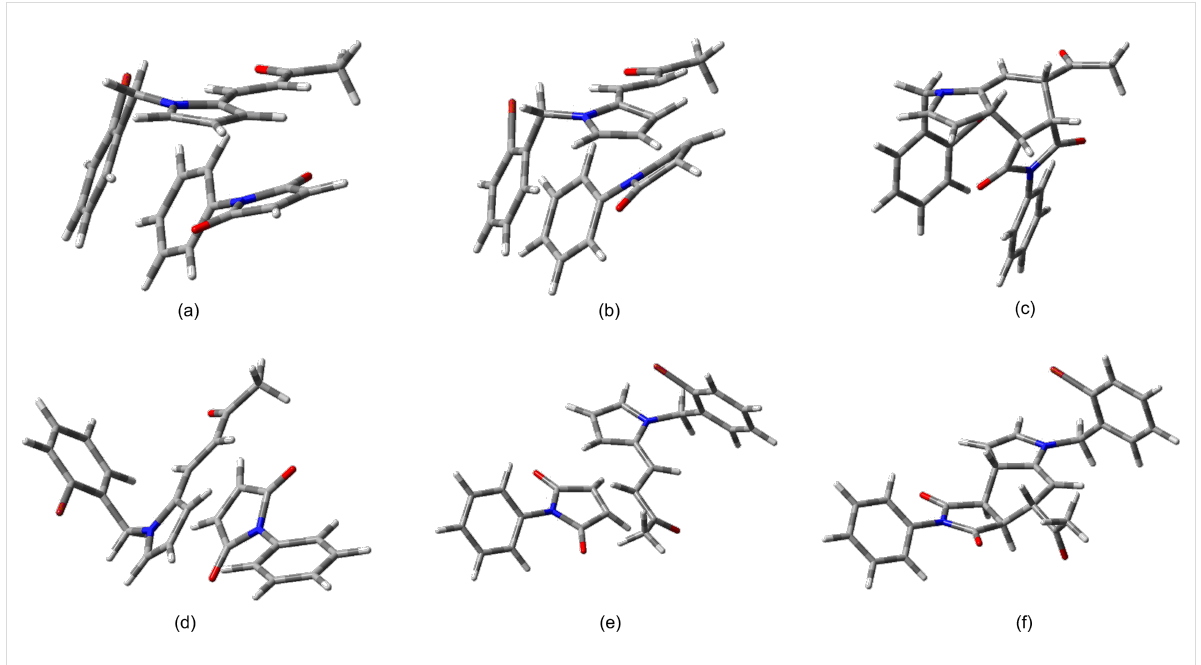
Figure 3: M06-2X/6-31+G(d,p) Optimized geometry for each of the SCs (a and d), TSs (b and e) and ADs (c and f) of the Diels–Alder reactions of diene 8g and dienophile 7c , for the endo (a–c) and the exo (d–f) approaches, respectively.